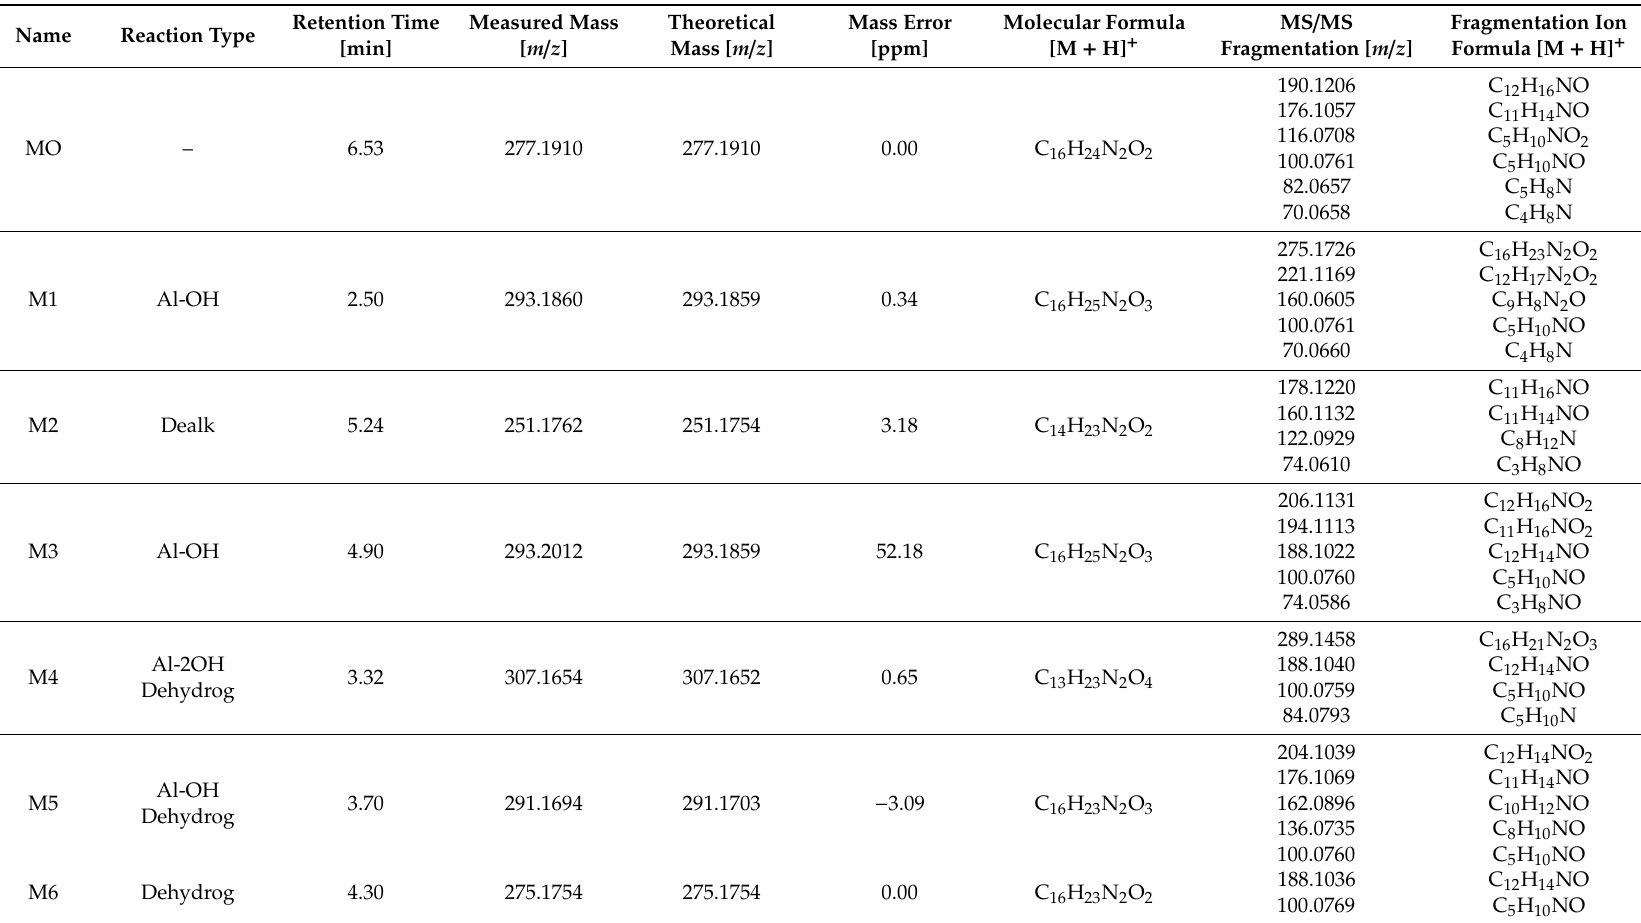
Table 1. Q-TOF accurate mass elemental composition and MS / MS fragmentation and of the analyzed